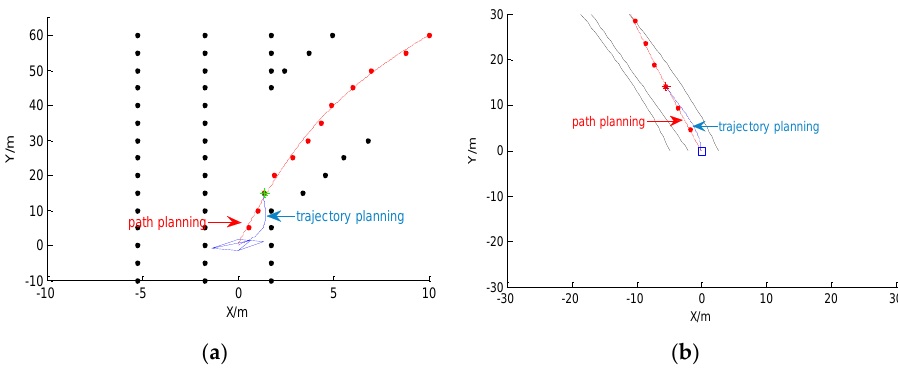
Figure 14. Ramp. ( a ) Global coordinates; ( b ) local coordinates.